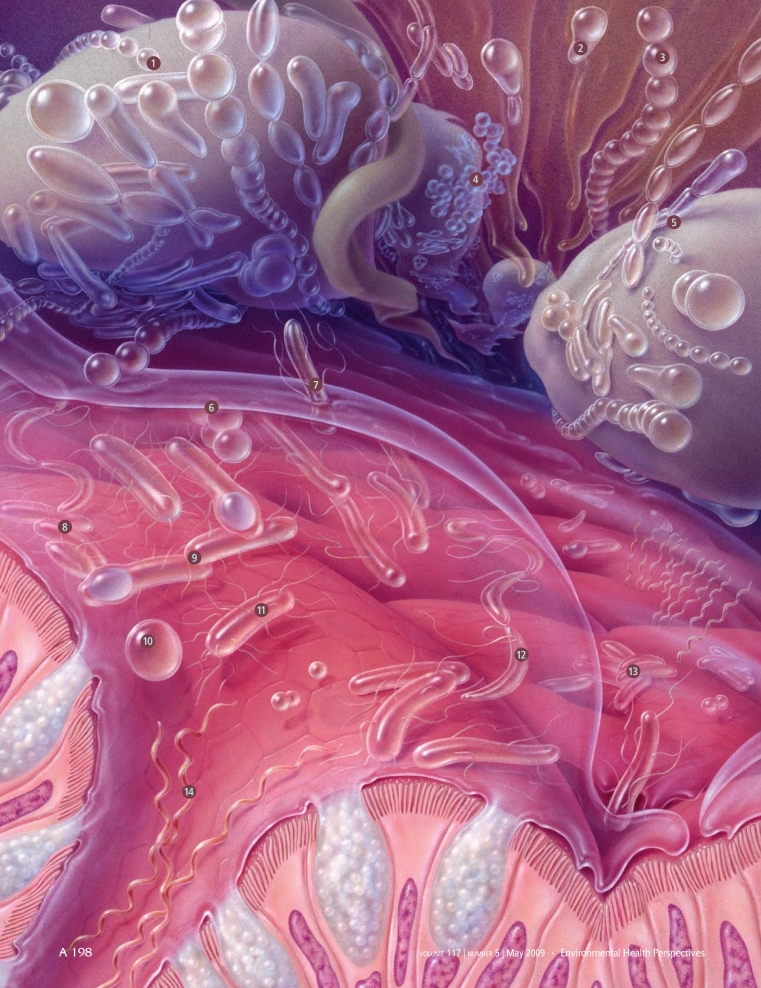
(opposite) The gut contains thousands of microbial species, including:1) Ruminococcus2) Bifidobacterium3) Peptostreptococcus4) Staphylococcus5) Lactobacillus6) Acidaminococcus7) Fusobacterium8) Eubacterium9) Clostridium10) Coprococcus11) Escherichia12) Butyrivibrio13) Bacteroides14) Brachyspira